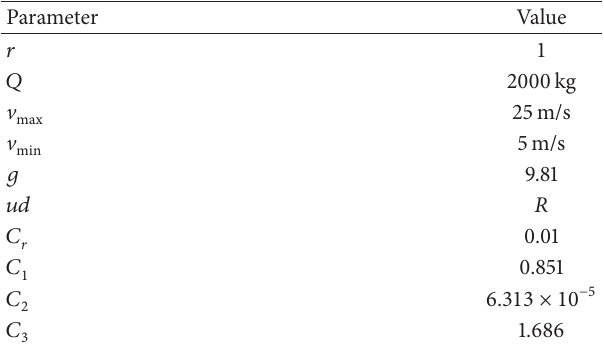
Table 5: The parameter values in the model.